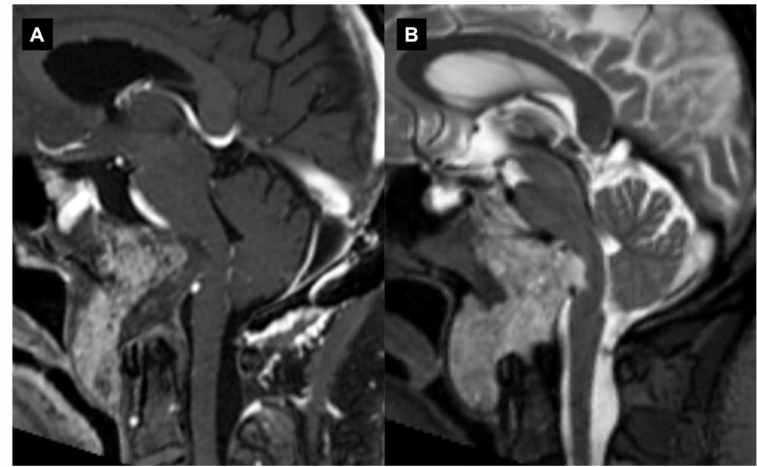
Figure 1. Craniovertebral junction chordoma. Sagittal ( A ) T1-weighted image after contrast and ( B ) T2-weighted image depicting a large chordoma invading the rhinopharynx and extending into the premedullary